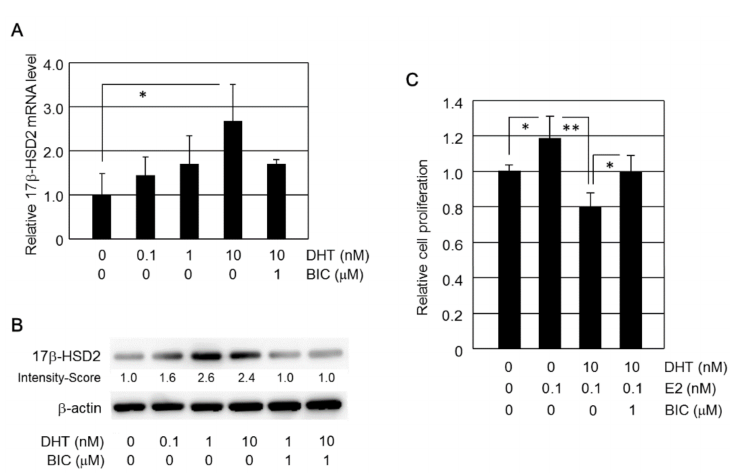
Figure 1. ( A ) Expression of ER α and AR proteins in endometrial cancer cell lines. ER α and AR proteins were detected by Western blotting. ( B ) Expression of 17 β -HSD2 mRNA in endometrial cancer cell lines. 17 β -HSD2 mRNA expression was examined using qRT-PCR. ( C ) Effect of DHT treatment on 17 β -HSD2 mRNA expression in Ishikawa cells; ( D ) effect of DHT treatment on 17 β -HSD2 mRNA expression in HEC-1A cells. ‘0’ denotes vehicle treatment alone; * p < 0.05.